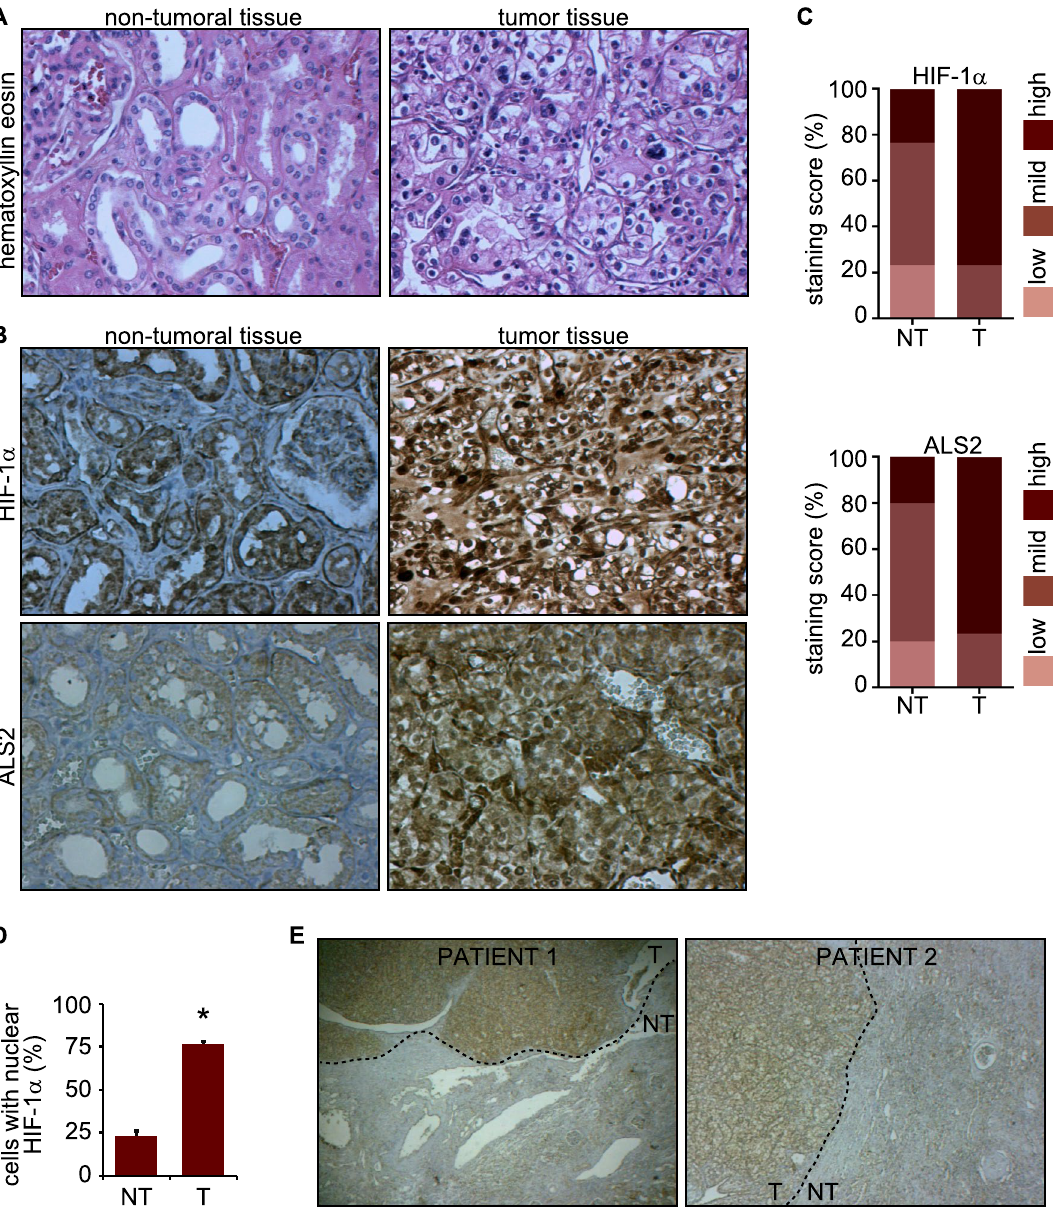
Figure 5. ALS2 is overexpressed in clear cell renal cell carcinoma biopsies. Biopsies with diagnosis of clear cell renal cell carcinoma and tumor free peritumoral region were used for histochemical analyses. ( A ) Representative images of hematoxylin eosin staining. ( B ) Tissue sections were incubated with primary antibodies against HIF-1α or ALS2, then incubated with peroxidase-streptavidin conjugates and visualized with diaminobenzidine, contrasted with Harry´s hematoxylin. ( C ) Percentages of staining scores (low, mild or high expression) for HIF-1α and ALS2 in tumor (T) and non-tumoral (NT) tissues. CCRCC samples, n = 30; and non-tumoral samples, n = 30 (data are summarized in Supplementary Fig. 3). ( D ) Percentage of cells with nuclear localization of HIF-1α, obtained from images as shown in ( B ). Quantifications were obtained as described in the materials and methods (mean ± SEM; t test; *** p ≤ 0.001). ( E ) Two different cases depicting tumor (T) and non-tumor (NT) regions within the same sample are